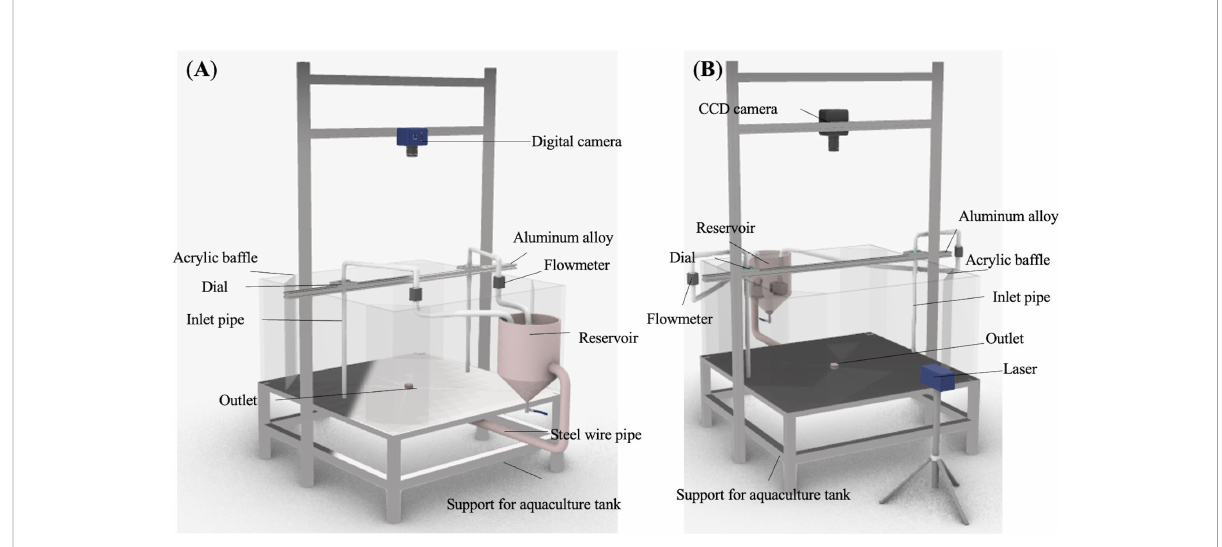
FIGURE 1 Con fi guration of the experiment setup: (A) Solid waste removal system; (B) PIV fl ow fi eld measurement